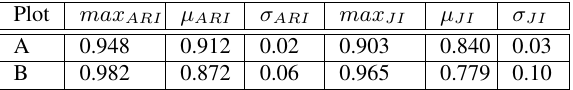
Table 2: Grid search - results